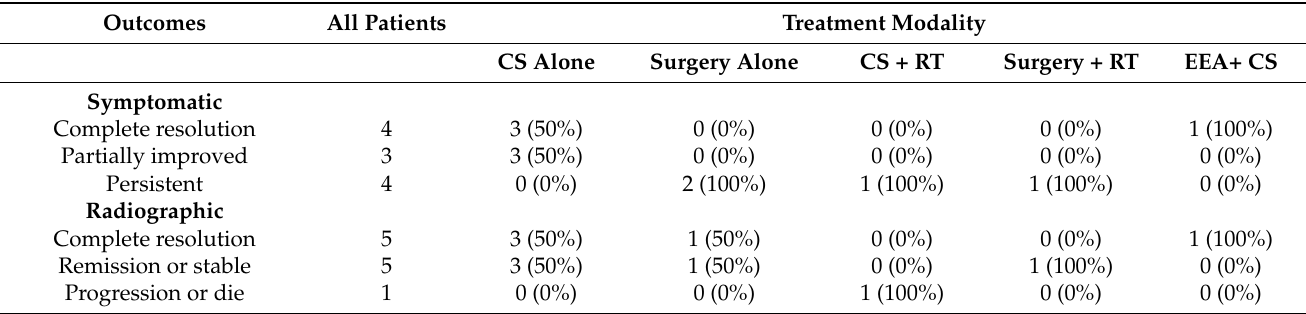
Table 2. Symptomatic and radiographic outcomes after different treatment modalities for patients with inflammatory pseudotumor with lower cranial nerve